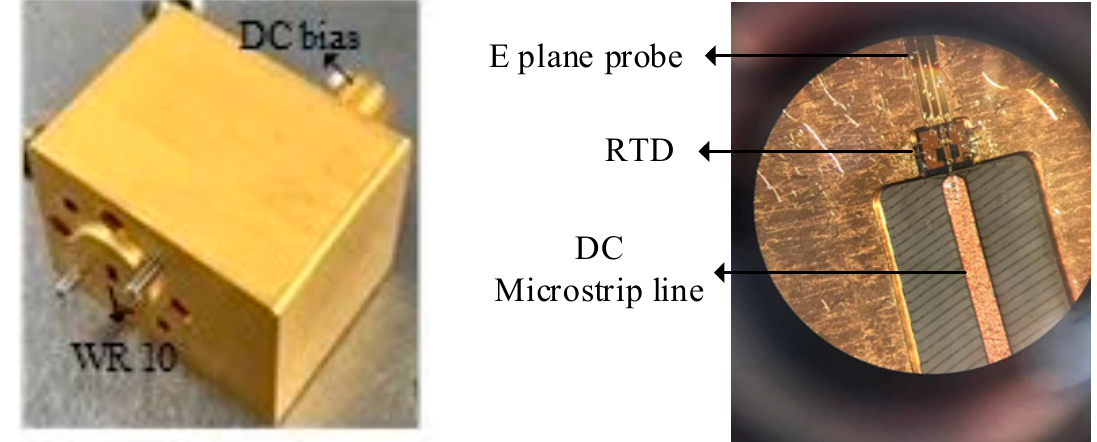
Figure 6. Photograph and micrograph of the RTD with a rectangular waveguide output.